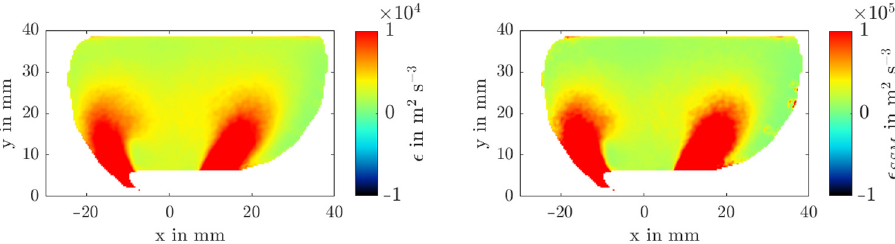
Figure 25. Rate of dissipation of the turbulent kinetic energy 𝜀 ( left ) and rate of dissipation of turbulent kinetic energy using the Smagorinsky sub-grid model (SSM) ε SSM ( right ), calculated from PIV measurements at 4 mm and 39.6 kg/h, terms involving third dimension z are set to zero.